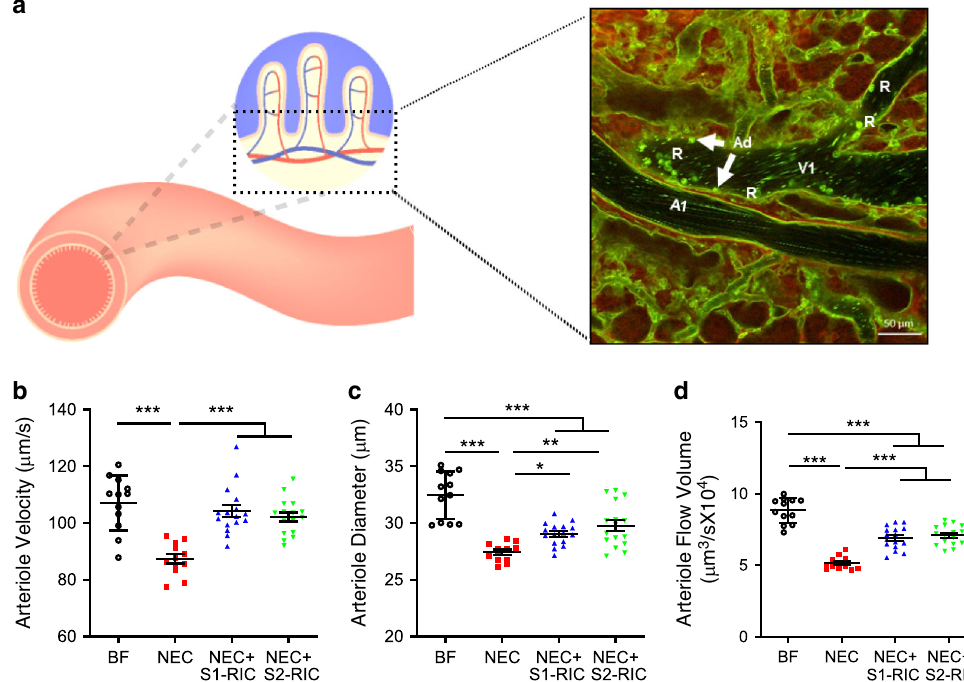
Fig. 4 RIC preserves intestinal microcirculation in the submucosa. a Depiction of submucosal arterioles (A1) and submucosal venules (V1) recorded via in vivo live imaging by TPLSM. Experiments were repeated independently 3 times, with similar results. Arteriole response in the ileal submucosa at P9 in terms of arteriole b blood fl ow velocity ( µ m/s), c diameter ( µ m), and d fl ow volume [( μ m) 3 /s] compared between breastfed (BF) control, NEC, NEC with Stage 1 RIC, and NEC with Stage 2 RIC groups (BF and NEC: n = 6; NEC + Stage 1 or 2 RIC: n = 8; minimum of 2 readings were obtained per group). Data were compared using two-sided one-way ANOVA with post hoc Turkey test (* p < 0.05; ** p < 0.01; **** p < 0.0001). Data are presented as mean ± SEM. Source data are provided as a Source Data fi